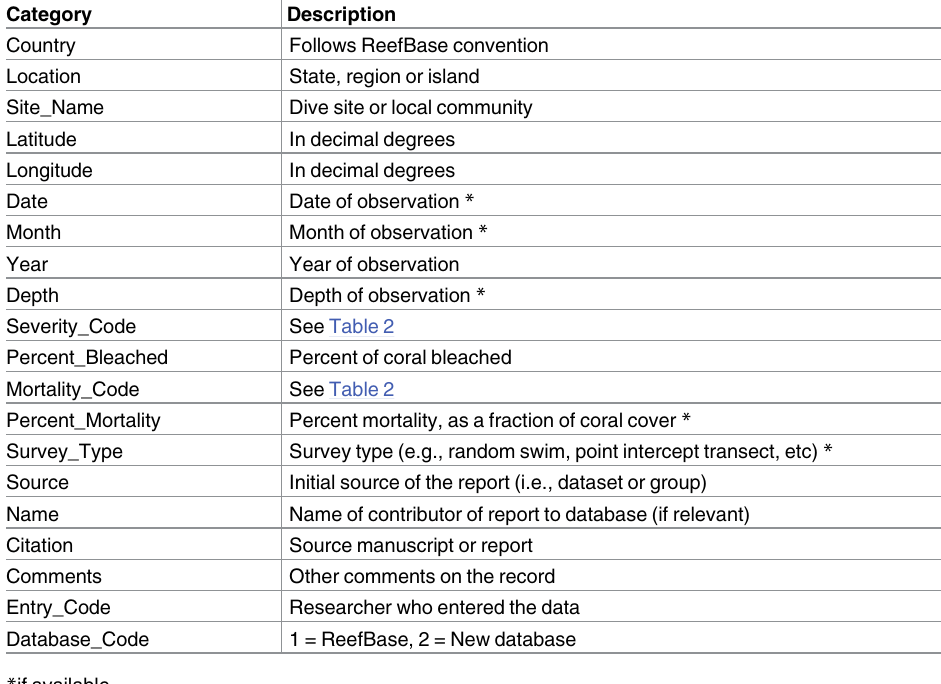
Table 1. Bleaching database